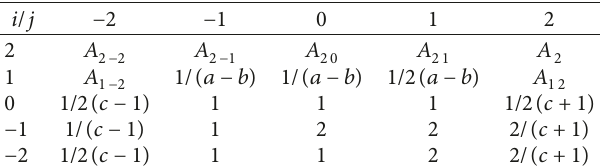
Table 1: Table for the coefficients A